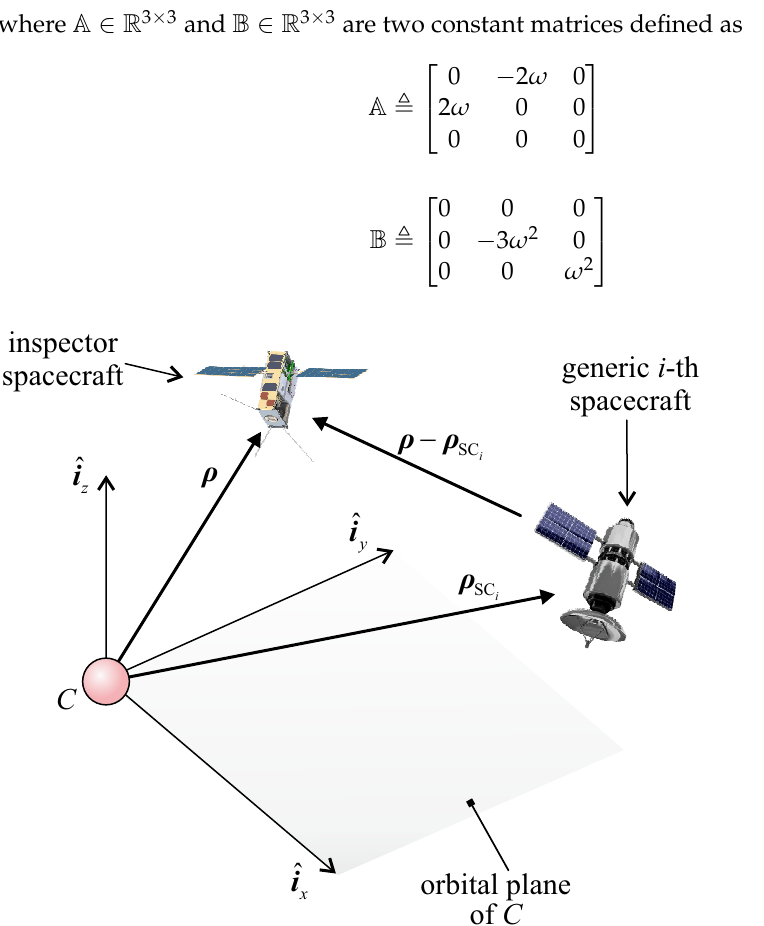
Figure 4. Spacecraft position vector in T H